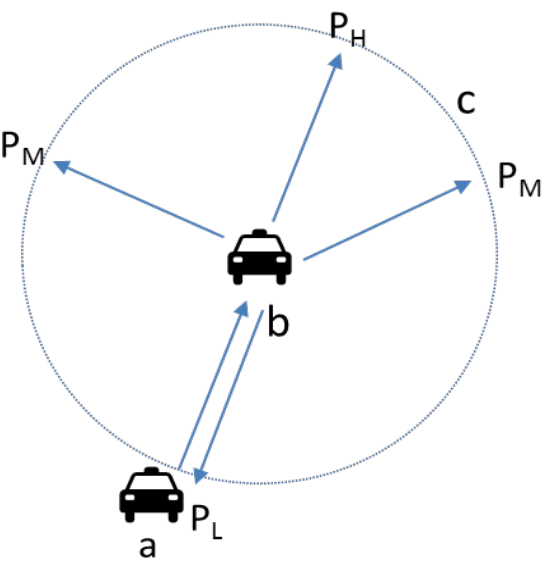
Figure 5. Vehicle location